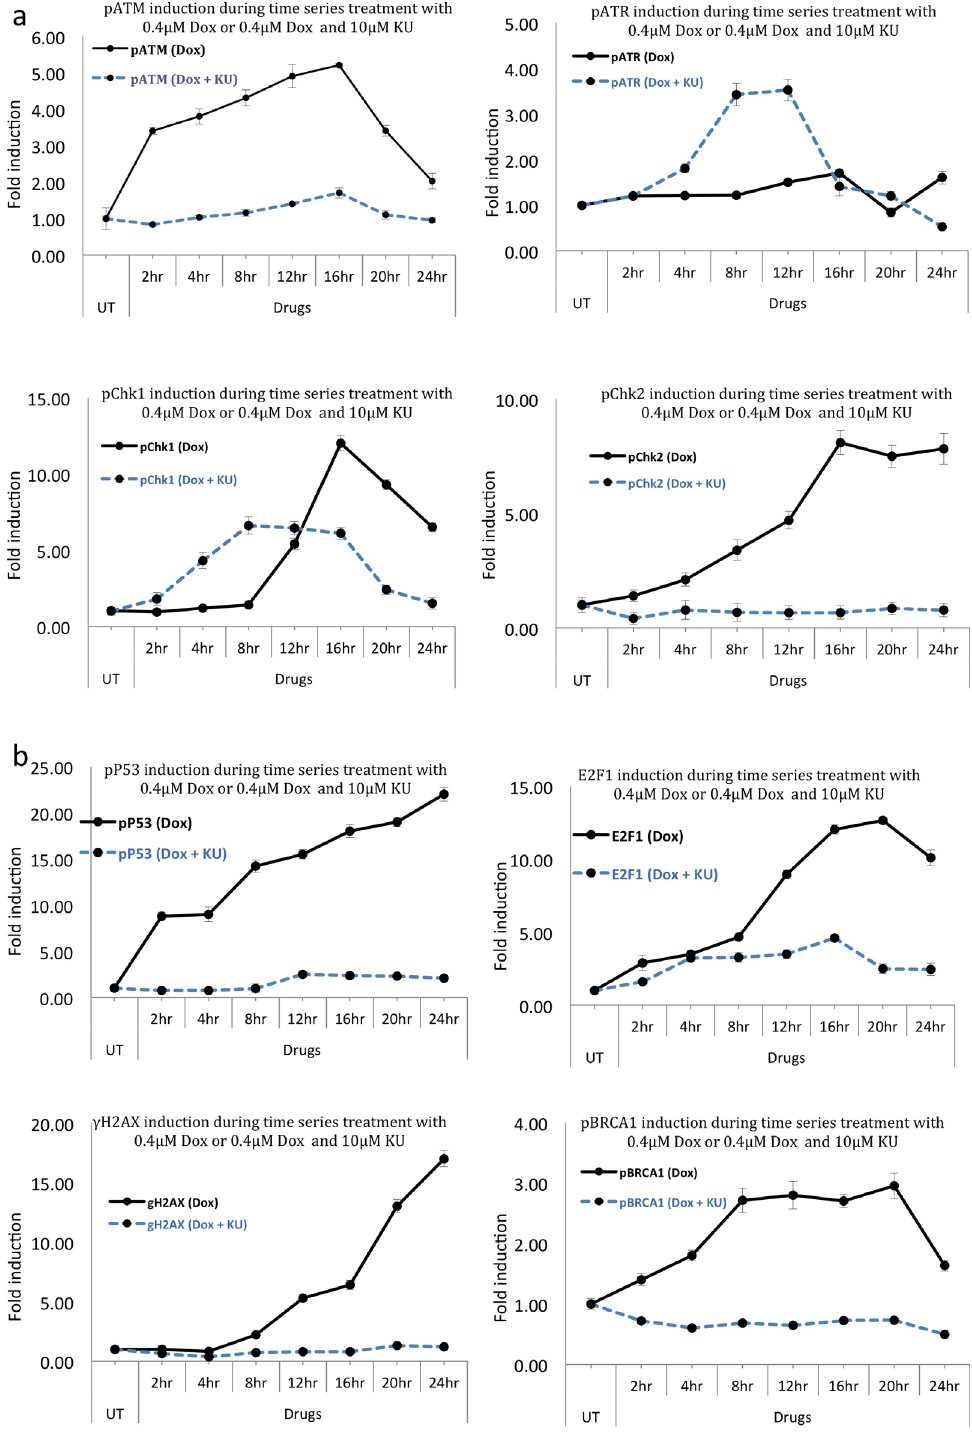
Figure 9. Time dependent double stranded DNA damage-induced signalling profiles of DDR transducers and effectors following 400nM Dox with and without ATM kinase inhibition. HaCat cells were seeded at a density of 2.5 x 10 3 cells in quadruplicates in 96-well plates. After 24 h, cells were either left untreated, treated with 100nM Dox alone or with a combination of 100nM Dox + 10μM KU for indicated time points and processed for ELISA as described in materials and methods. Following this, cells in each well were incubated with primary antibody against (a) DDR kinases pATM S-1981, pATR S-428, pChk1 S-345 and pChk2 T-68 and (b) DDR substrates pP53-S 15, γH2AX S-139, E2F1 and pBRCA1 S-1524 as indicated in figure and Horseradish peroxidase conjugated secondary antibody (Cell Signalling) followed by using Amplex Red® (Invitorgen) detection system. Readings were taken in 96-well fluorescence multi plate reader (Modulus Template®) using excitation and emission spectra of 530.590 nm. Values are means of fluorescent readings acquired from quadruplicates of treatments and normalised to the mean fluorescence of untreated control (UT) expressed as 1. Data is based on n=3 independent